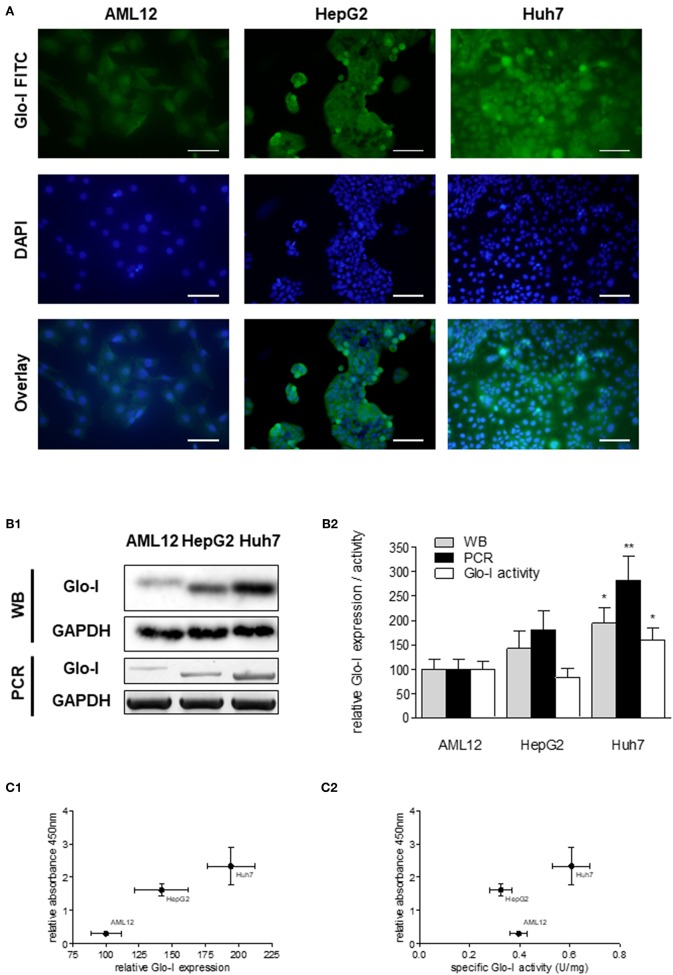
Expression and specific activity of Glo-I in HCC cell lines. (A) Immunofluorescence staining of Glo-I in AML12, HepG2, and Huh7 cell lines. Glo-I-FITC signal is shown in green color (upper row), staining of nuclei with DAPI can be found in the middle row. Overlay of Glo-I and DAPI staining (lower row) indicates cytosolic expression in all cell lines, with highest expression in Huh7. Scale bars: 100 μm. (B1), Protein and mRNA analysis of Glo-I expression was compared among the three cell lines by Western Blot and RT-PCR. Quantifications (B2) revealed expression of both mRNA and protein level to be highest in Huh7 cell line, as compared to HepG2 and AML12. (C1) Correlation of relative Glo-I expression and cell proliferation among AML12, HepG2, and Huh7 indicated highest relation in Huh7. (C2) Likewise, correlation of specific enzymatic activity of Glo-I (U/mg) and cell proliferation showed highest relation in Huh7 cell line. Results are represented as mean ± S.D. of at least three independent experiments. *P < 0.05, **P < 0.01.